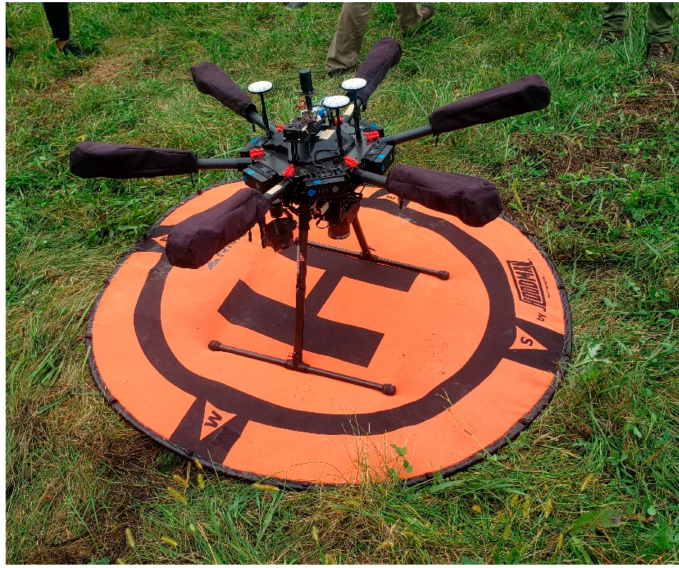
Figure 1. The M600 on a landing